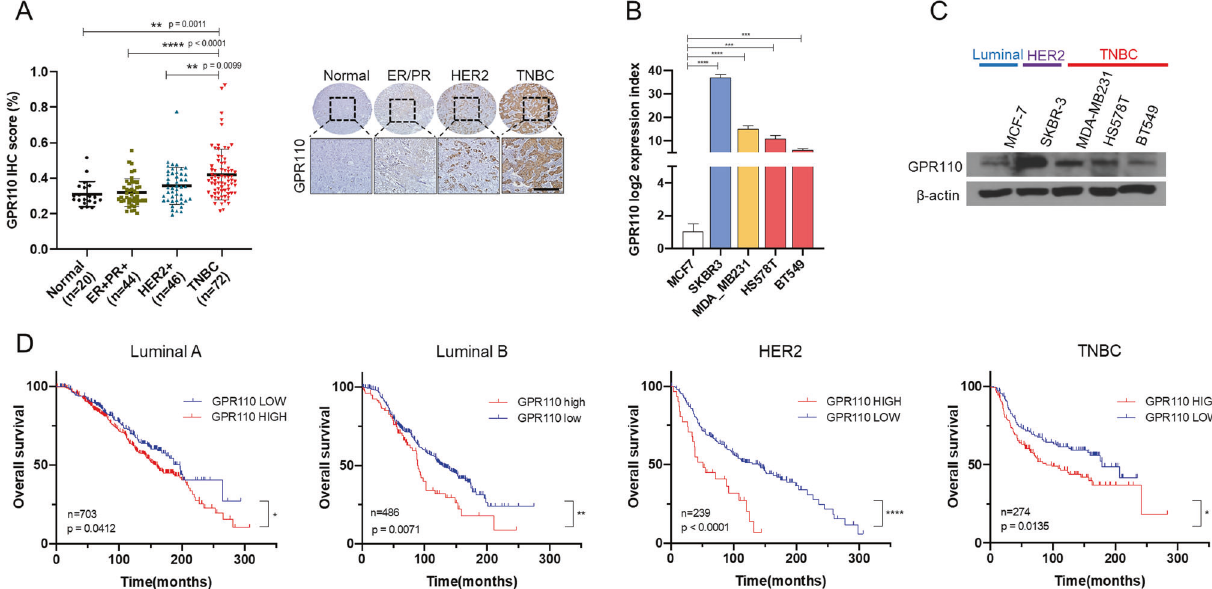
Fig. 1 GPR110 was highly expressed in triple-negative breast cancer. A Representative IHC images of GPR110 staining in invasive ductal carcinoma (IDC) cancer tissue and the quanti fi cation graph. Image J software was used for analysis. B , C qRT-PCR analysis and Western blotting showed the expression of GRP110 in cell lines from the Luminal, Her2 + , TNBC subtypes. D Kaplan – Meier survival analysis showed that high expression of GPR110 was associated with poor prognosis of Luminal A, Luminal B, Her2 + , and TNBC type patients. * p < 0.05, ** p < 0.001, *** p = 0.0001 and **** p < 0.0001; ns not signi fi cant; determined by two-tailed Student ’ s t test (95% con fi dence